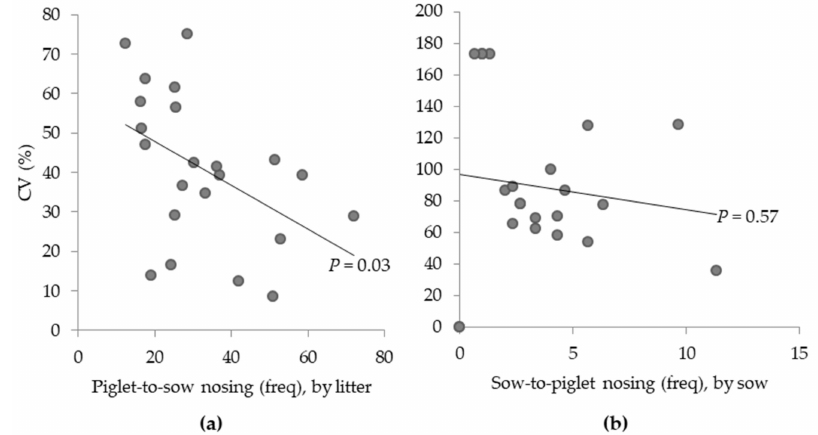
Figure 5. Coe ffi cient of variation (CV; %) for the average frequency (per 30 min of observation) of piglet-to-sow nosing ( a ) and sow-to-piglet nosing ( b ) behaviours across the lactation period ( n = 22